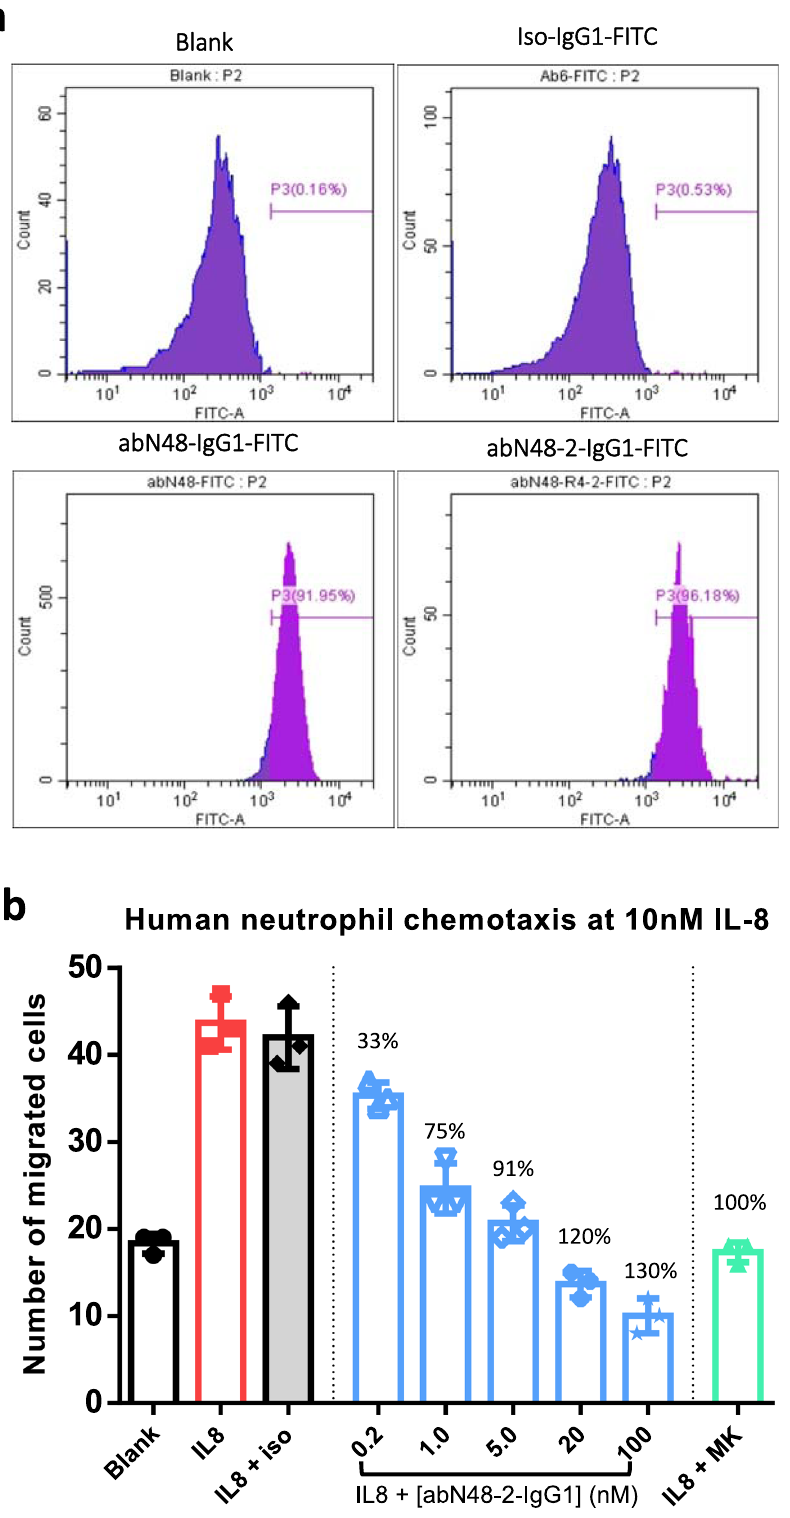
Fig. 4 Inhibition of IL-8 induced neutrophil chemotaxis. a Representative fl ow-cytometry results showing abN48-IgG1 and abN48-2-IgG1 (FITC- conjugated) speci fi cally bind to human primary neutrophils. Blank: cells without h CXCR2 expression; iso-IgG1-FITC: irrelevant human IgG1 antibody conjugated with FITC. (3 independent biological replicates showed the same results) b Inhibition of abN48-2-IgG1 on IL-8 (10 nM) induced neutrophil chemotaxis was determined by a chemotaxis assay. Blank: media without IL-8 or inhibitor; IL-8: 10 nM IL-8; iso: 10 nM irrelevant human IgG1 antibody; MK: 1 μ M small molecule CXCR2 inhibitor MK7123. The values of percentage (%) above the blue and green bars represent the percentage of inhibition of neutrophil chemotaxis induced by IL-8 at various concentrations of abN48-2-IgG1 and 1 μ M MK7123, respectively. ( n = 3 independent cell samples measured in a single experiment, data presented as dots overlapped with mean (column) ± s.d. (error bars). 3 independent experiments with different samples and antibody concentrations showed consistent